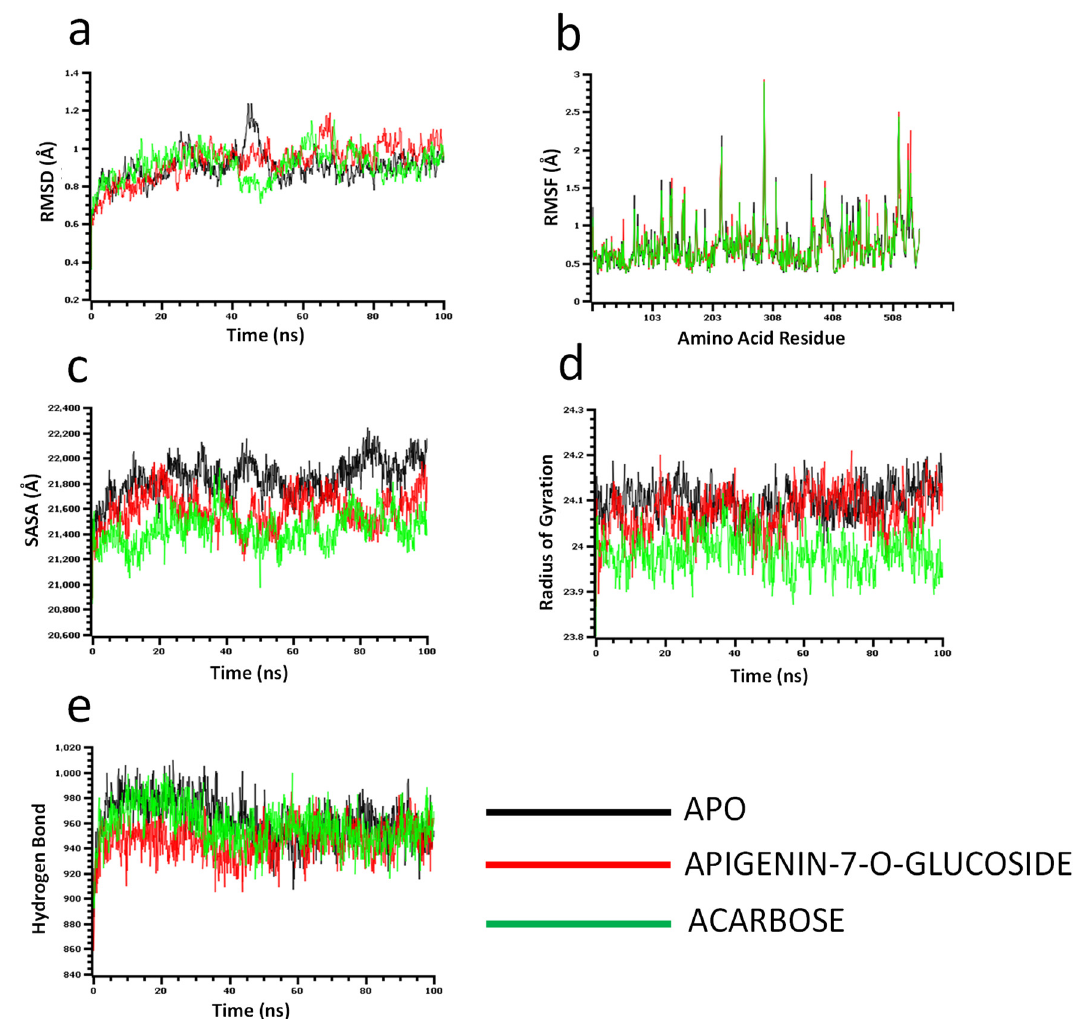
Figure 5. Molecular dynamics simulation for alpha-glucosidase. Analysis of ( a ) RMSD (Root Mean Square Deviation); ( b ) RMSF (Root Mean Square Fluctuations); ( c ) SASA (Solvent Accessible Surface Area) ( d ) Rg (Radius of Gyration); and ( e ) Binding free energy.